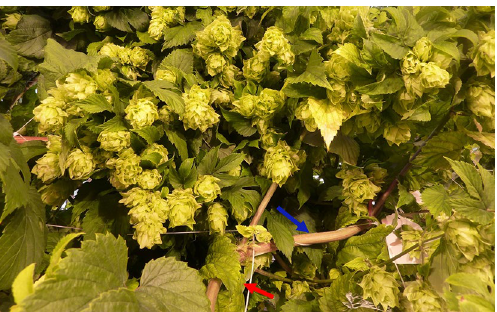
Figure 3. Representative example of cultivar ‘Centennial’ hop cone production within a subsection of crown guided through netting (67 days into the crop cycle). The red arrow indicates the local internode strain location at the junction of the netting 15.25 cm vertical rise transition to the 15.25 cm run and the blue arrow indicates the subsequent 15.25 cm horizontal